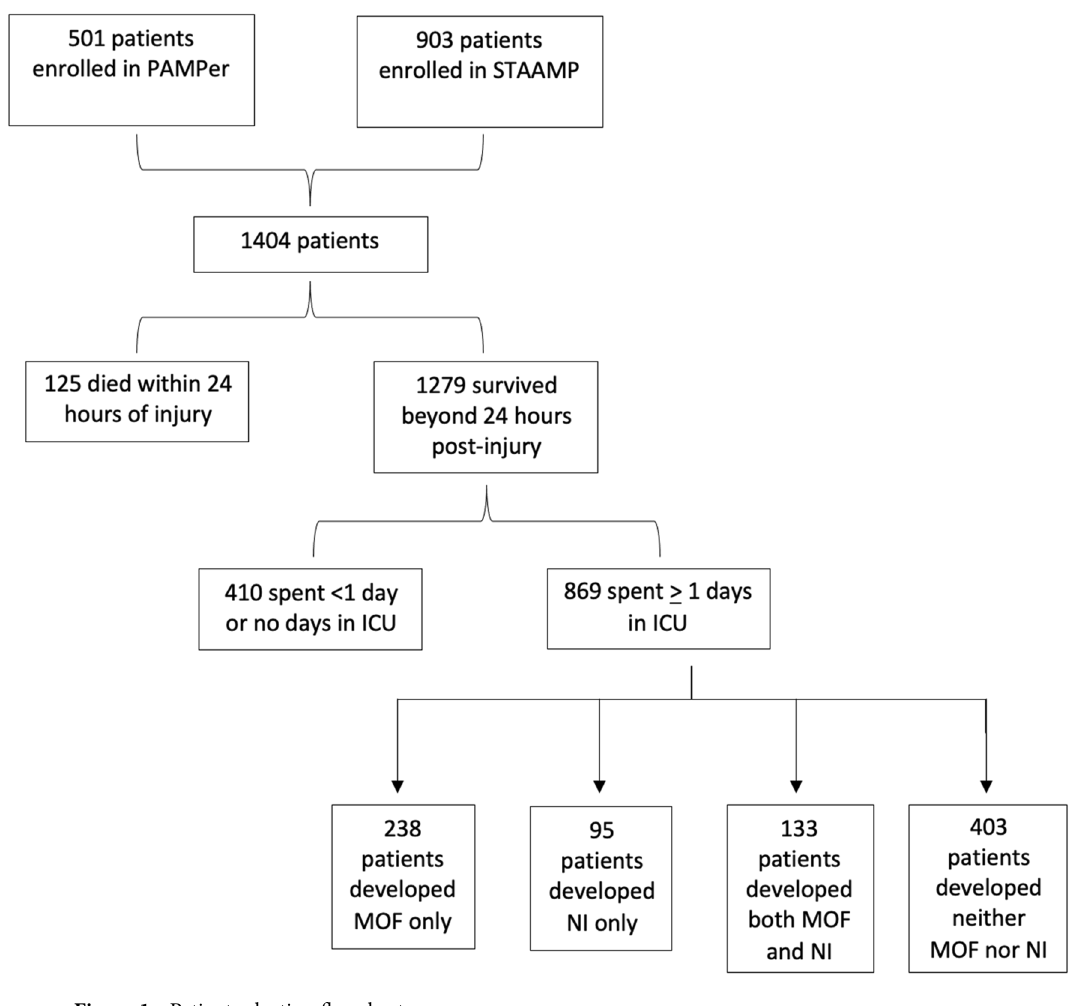
Figure 1. Patient selection